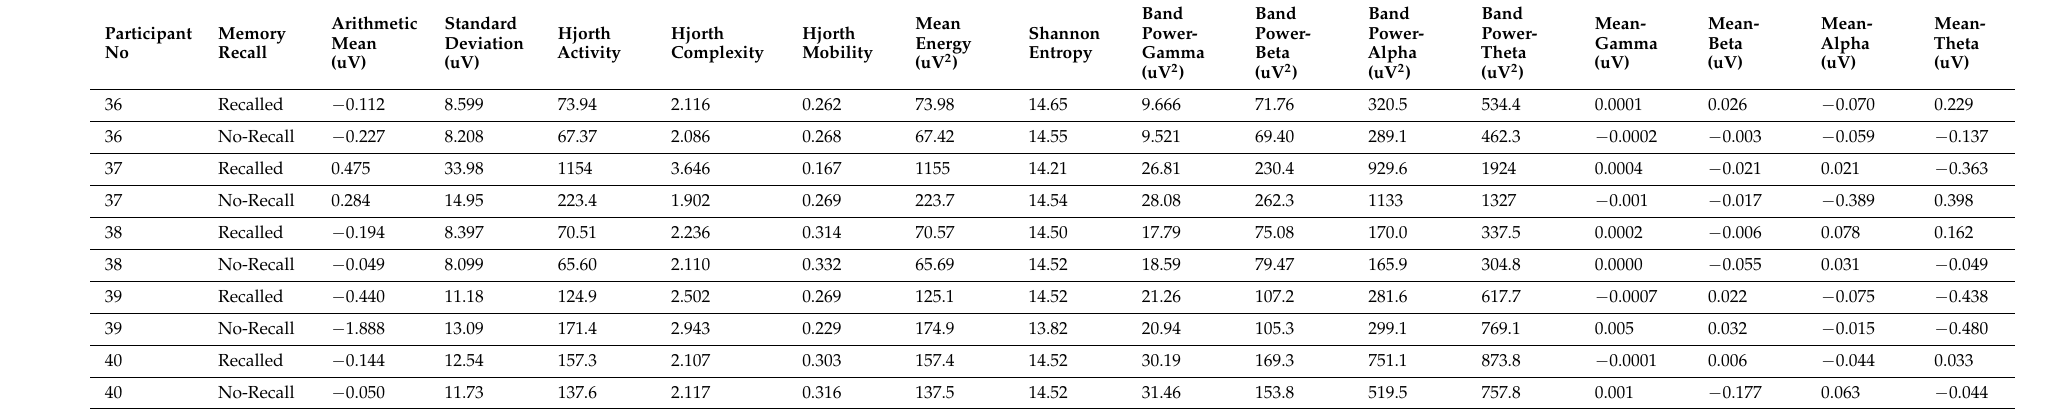
Table 3. Sample of extracted EEG features for F3